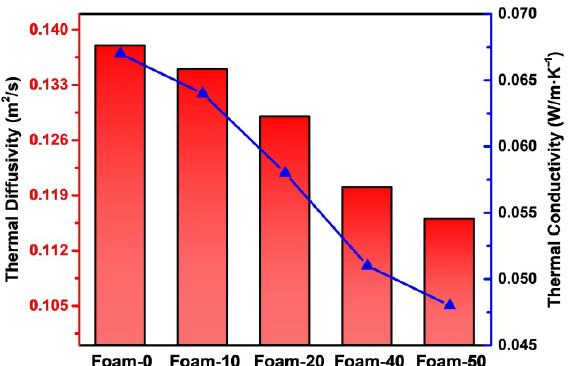
Figure 5. Thermal diffusivity and thermal conductivity of composite foams.